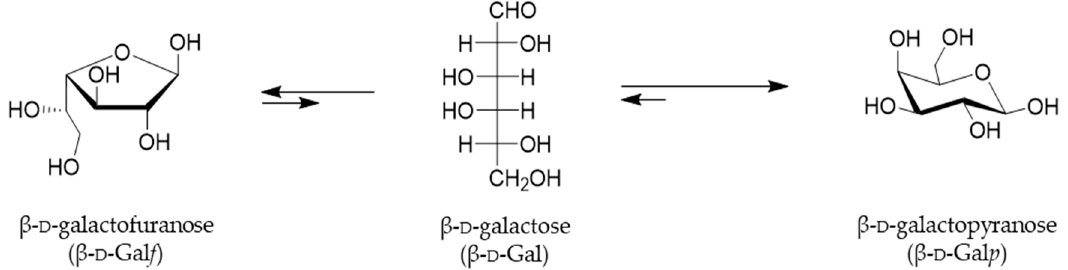
Figure 1. Representation of the equilibria between cyclic forms of D -galactose in solution. The rapid interconversion of cyclic Gal f and Gal p takes place through an acyclic form, and the favorable equilibrium for Gal p are indicated by the arrows [3].